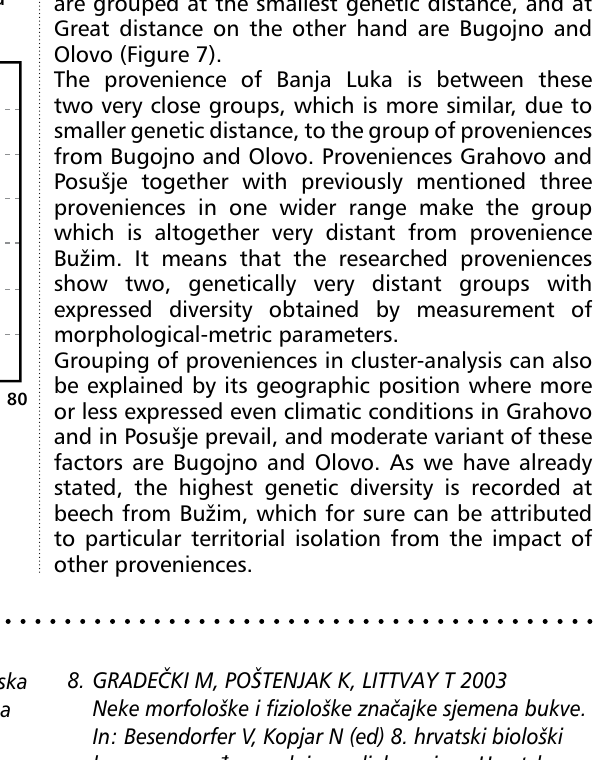
varijabilnosto obične bukve. In: Matić S (ed.) Obična bukva (Fagus sylvatica L.) u Hrvatskoj. Akademija šumarskih znanosti, Zagreb, p 247-255 2. StOJAnOvIć LJ, KRStIć M 2005 Gajenje bukovih šuma. In: Bukva (Fagus moesiaca /Domin, Mally/ Czeczott.) u Srbiji. Udruženje šumarskih inženjera i